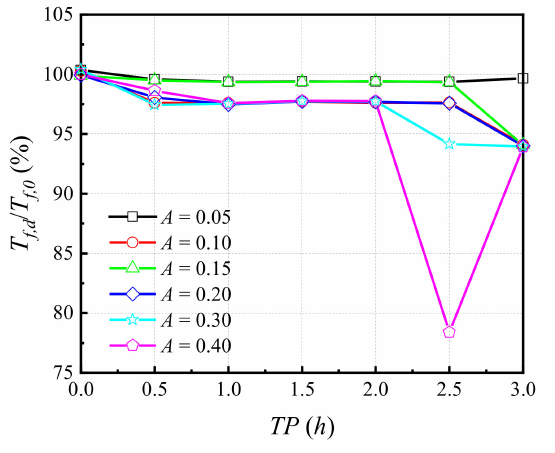
Figure 16. Effect of amplitude and TP of cyclic load on fire resistance